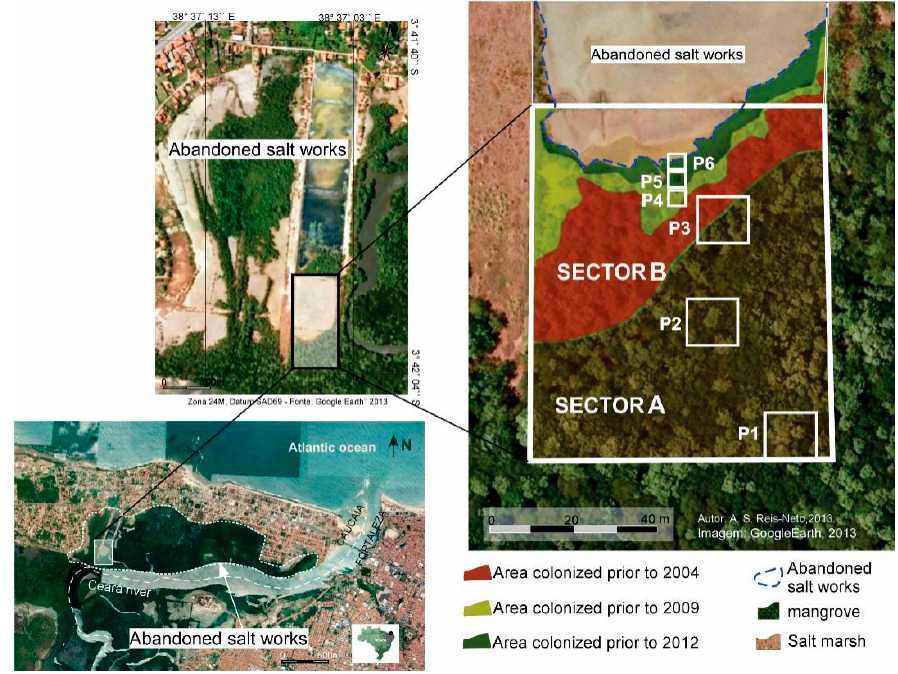
Figure 5. Identification of the different zones of expansion of the mangrove forest in an abandoned salt evaporation pond in the Margarida saltworks, between 2004 and 2012.